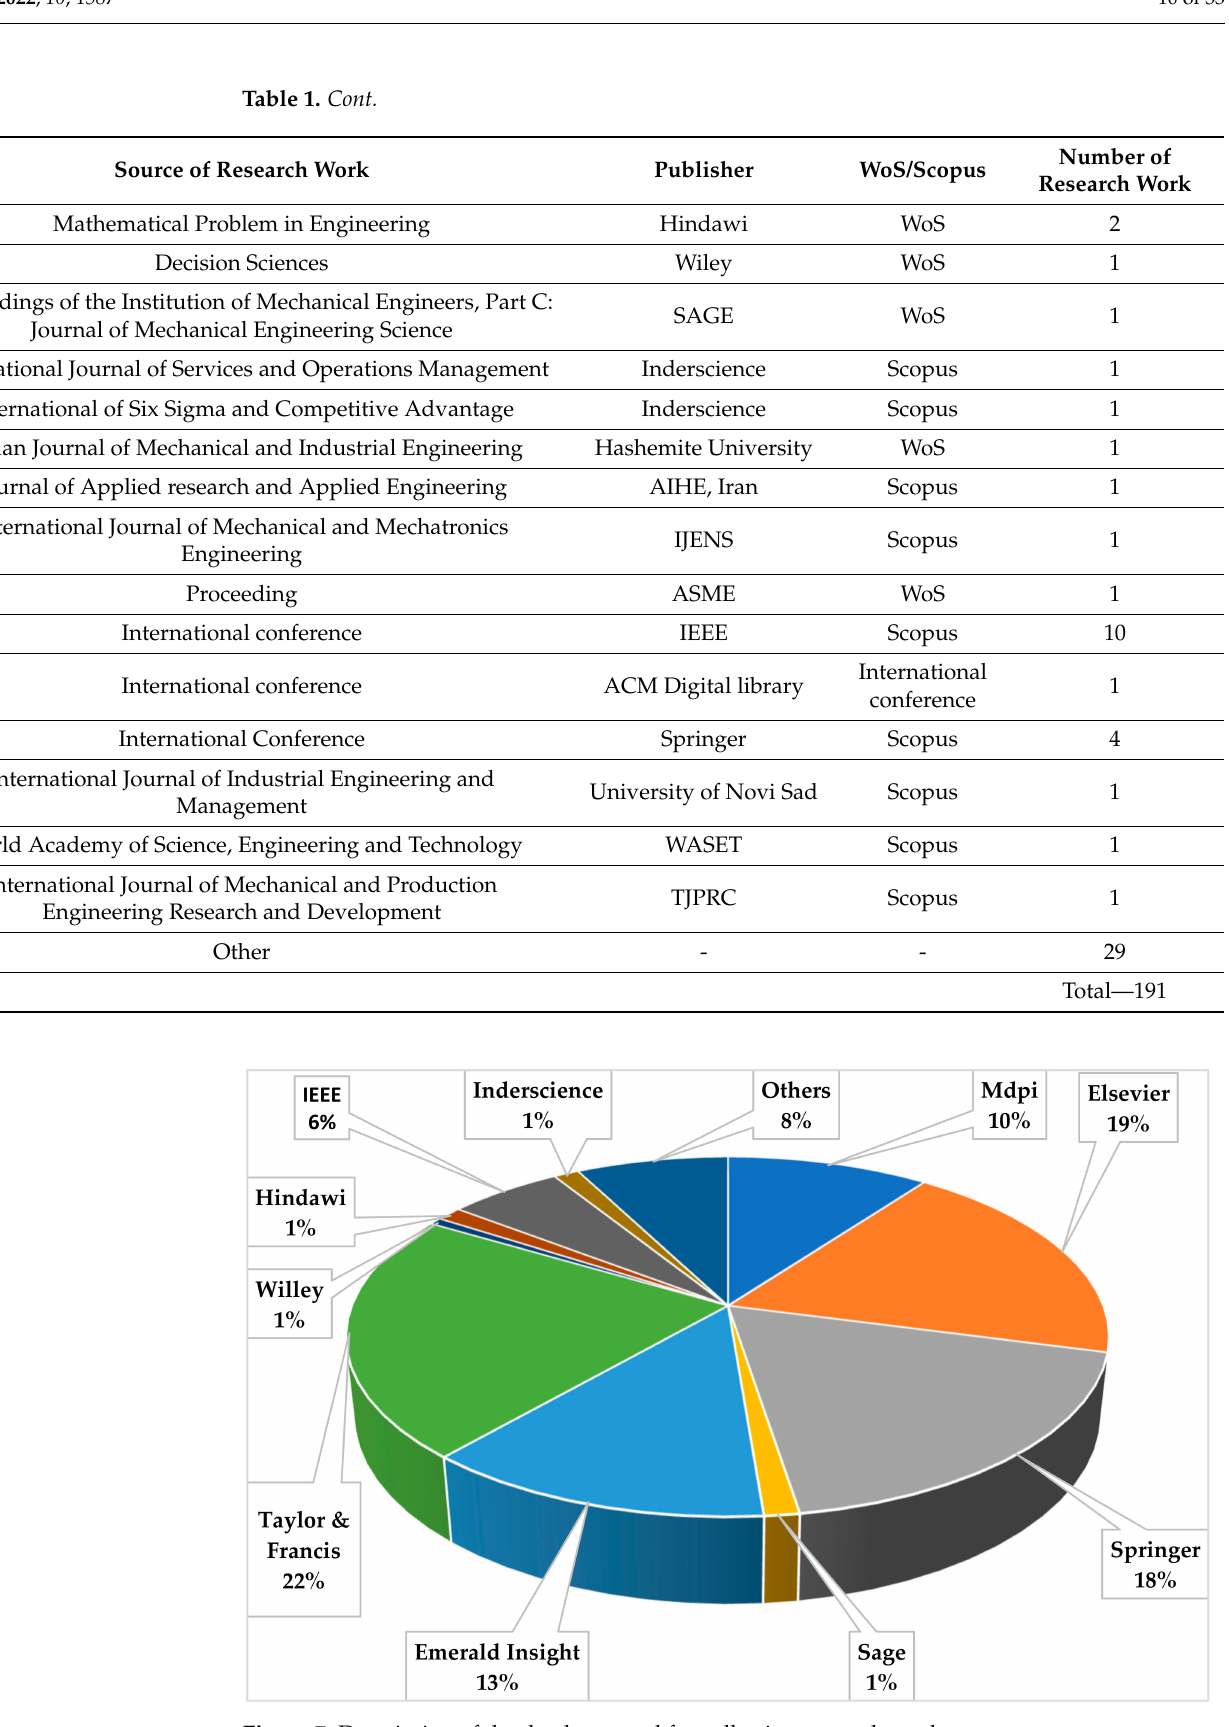
Figure 7. Description of the database used for collecting research